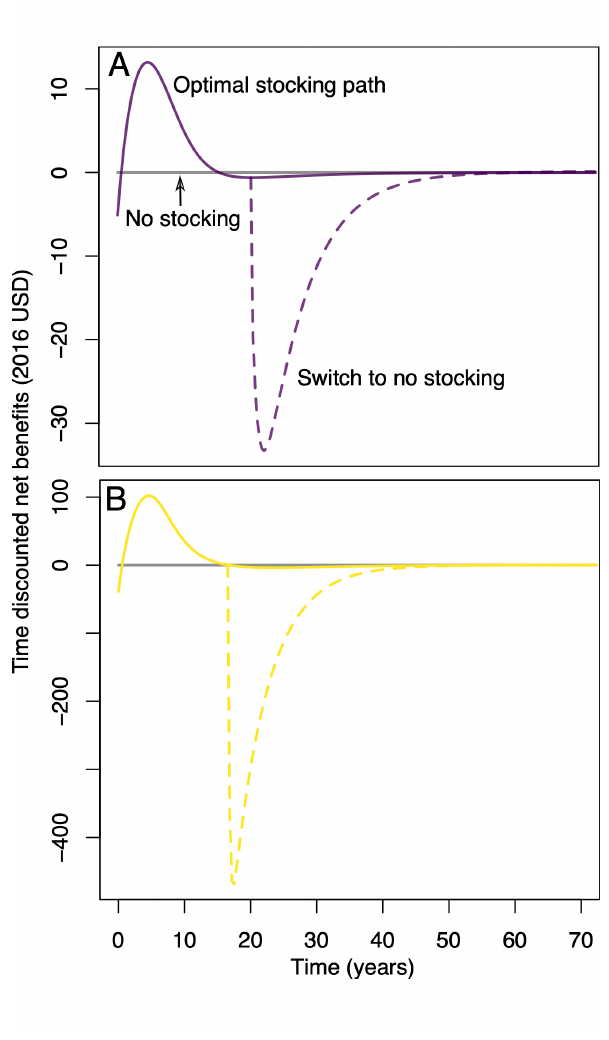
Fig. 2 . Welfare accrues during the transition to equilibrium, even though rents are dissipated at equilibrium, under (A) local management and (B) centralized management. Starting from the no-stocking open access equilibrium, we considered three scenarios. First, if there is no stocking (grey line), the system remains at the open access equilibrium and net benefits are zero over the entire time horizon. Second, if stocking follows the welfare-maximizing optimal path (solid line), net benefits are initially negative because costs but not benefits of stocking have been realized; become positive and then negative again as effort responds sluggishly to changes in the fishery; and finally re- equilibrate at the open access equilibrium. Third, switching from the optimal stocking path to no stocking (dashed line) does not yield gains in welfare, regardless of the time point at which the switch is made, because ceasing to stock produces negative net benefits for anglers as effort declines and the system transitions to